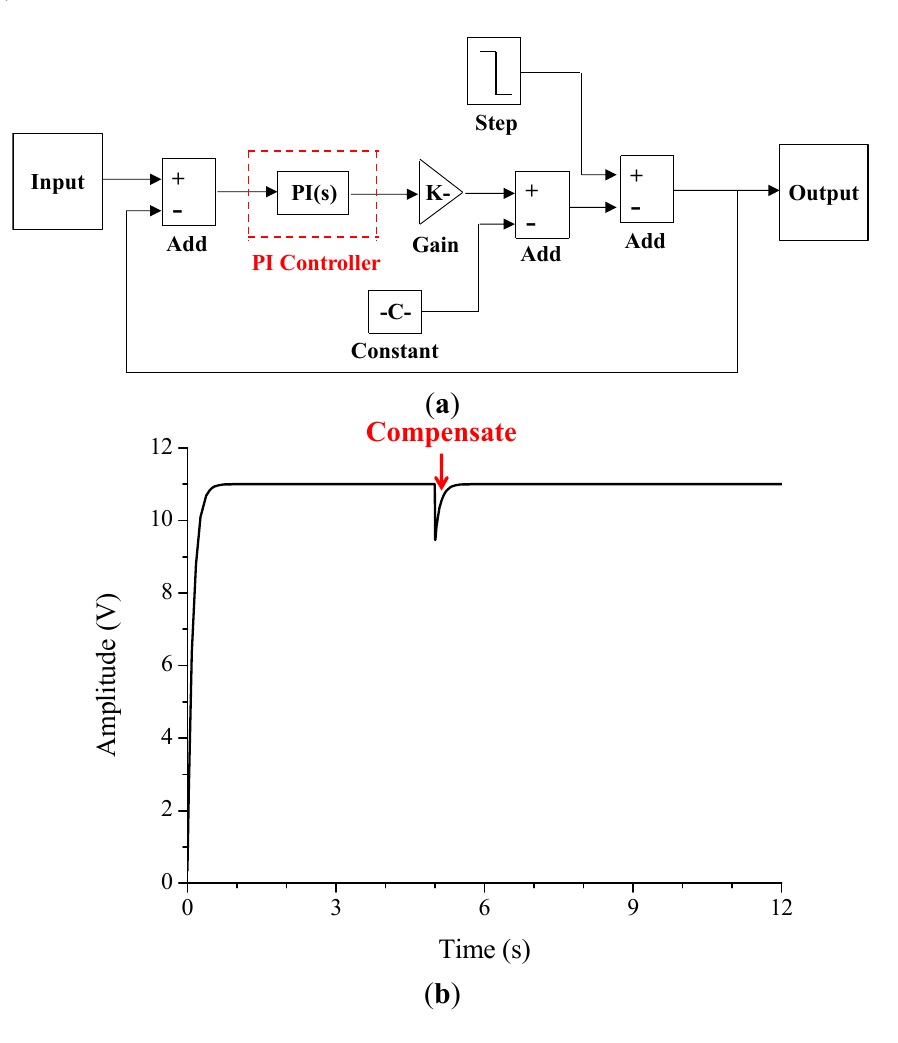
Figure 10. PI controller verification. ( a ) Block diagram for verification. ( b ) Measured result of time